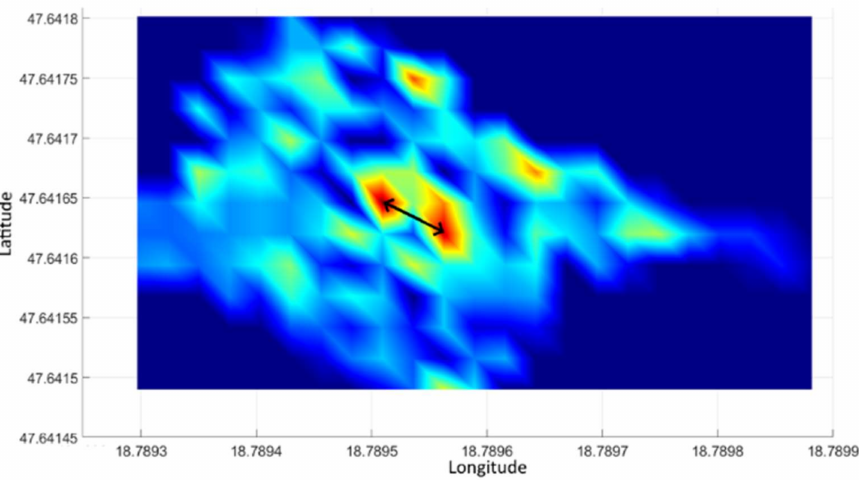
Figure 10. Distribution of gamma radiation intensity in the test area using the parameters of previous